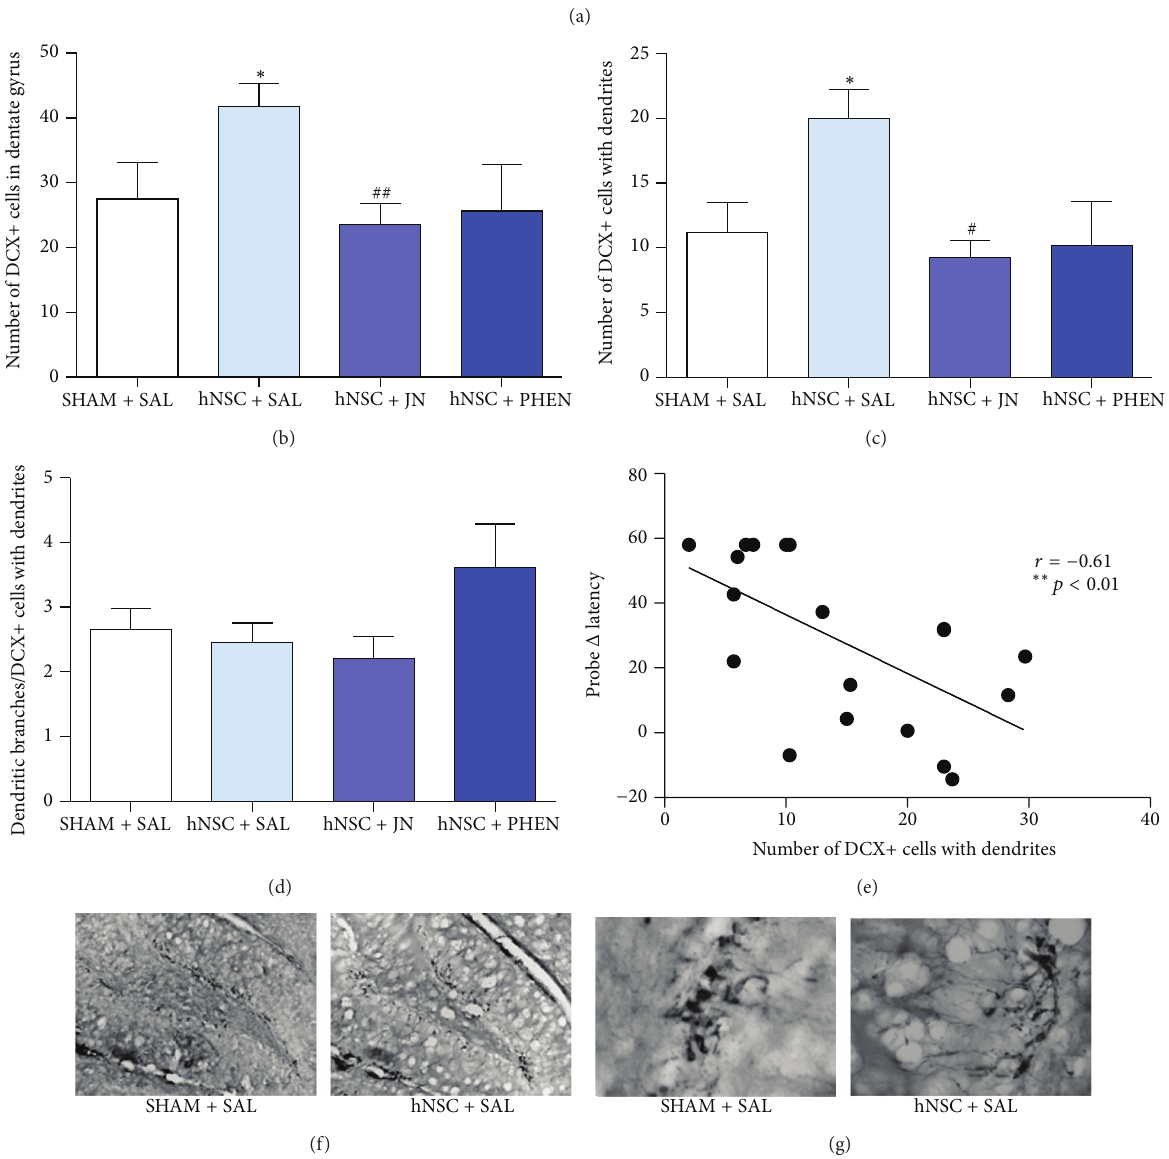
Figure 2: hNSC transplantation increases the number and the maturation of new neurons in the dentate gyrus. (a) Doublecortin- (DCX-) labeledcellsinthedentategyrus(DG)ofTg2576micewerecharacterizedaccordingtotheirnumbersandthelevelofmaturationanddendritic arborization. (b) The total number of DCX+ cells, (c) the number of DCX+ cells possessing dendrites, and (d) the average number of dendritic branches on DCX+ cells in the DG in mice receiving SHAM (vehicle only) transplantation and saline (SHAM + SAL) or mice receiving hNSC transplantation and saline (hNSC + SAL), JN403 (hNSC + JN), or (+)-phenserine (hNSC + PHEN). (e) Correlation between the number of DCX+ cells with dendrites and the difference in time taken to find the position of the platform ( Δ latency; follow-up probe test values minus baseline acquisition values) in the Morris water maze task in groups of Tg2576 mice treated with hNSC + SAL, hNSC + JN, and hNSC + PHEN ( 𝑟 = −0.61 ; ∗∗ 𝑝 < 0.01 , 𝑛 = 18 ). Representative images of immunostaining with DCX+ cells in the DG of TG2576 mice at (f) 10x and (g) 20x magnification. ∗ 𝑝 < 0.05 compared to SHAM + SAL, # 𝑝 < 0.05 and ## 𝑝 < 0.01 compared to hNSC + SAL. The data are expressed as means ±